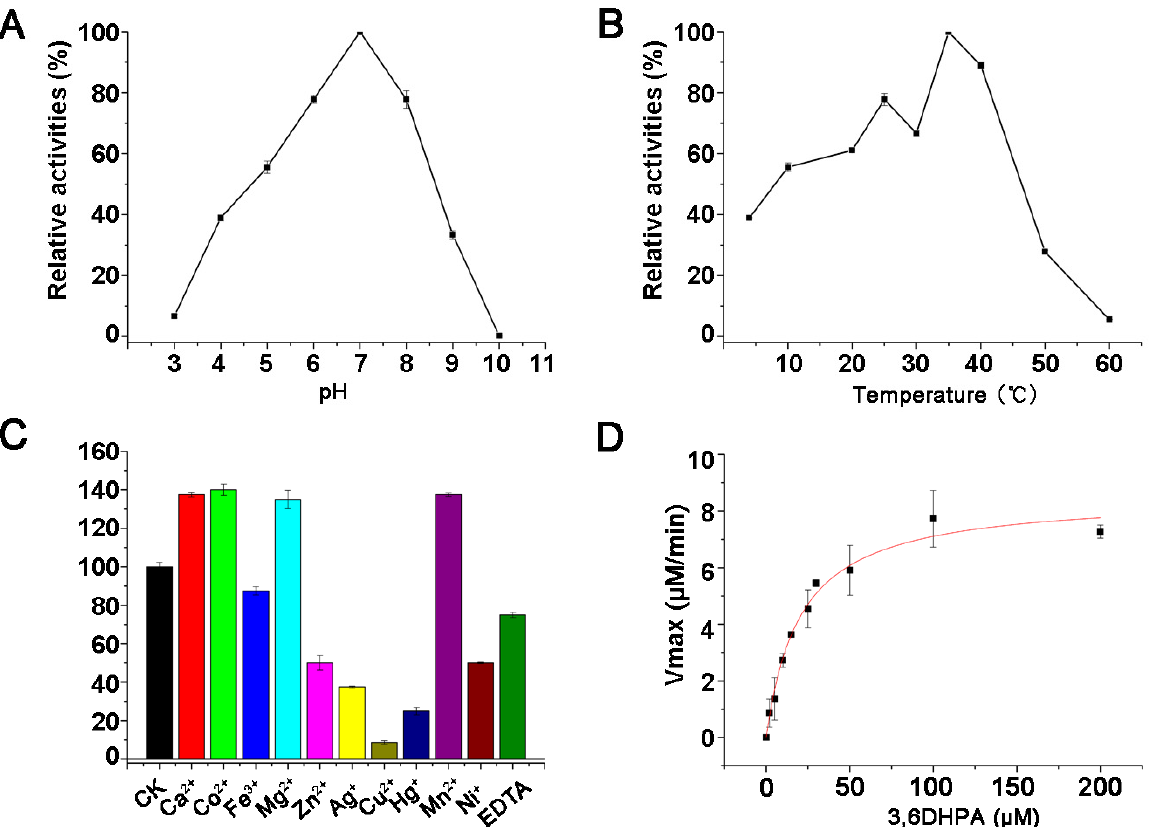
Figure 4. Characterization of PicC RB50 . ( A ) Effect of pH on enzyme activity of PicC RB50 . ( B ) Effect of temperature on enzyme activity of PicC RB50 . ( C ) Effect of metal ions on enzyme activity of PicC RB50 . ( D ) The kinetic curve of PicC RB50 . The Data were shown in means ± S.E.M.